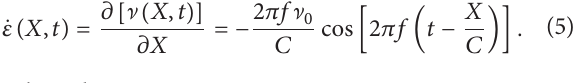
of dynamic load on coal and rock by man-made parameters of dynamic shockwave [11–13]. These research methods are not involved in the characteristics of mining dynamic load, so that the reliability and effectiveness for study results are